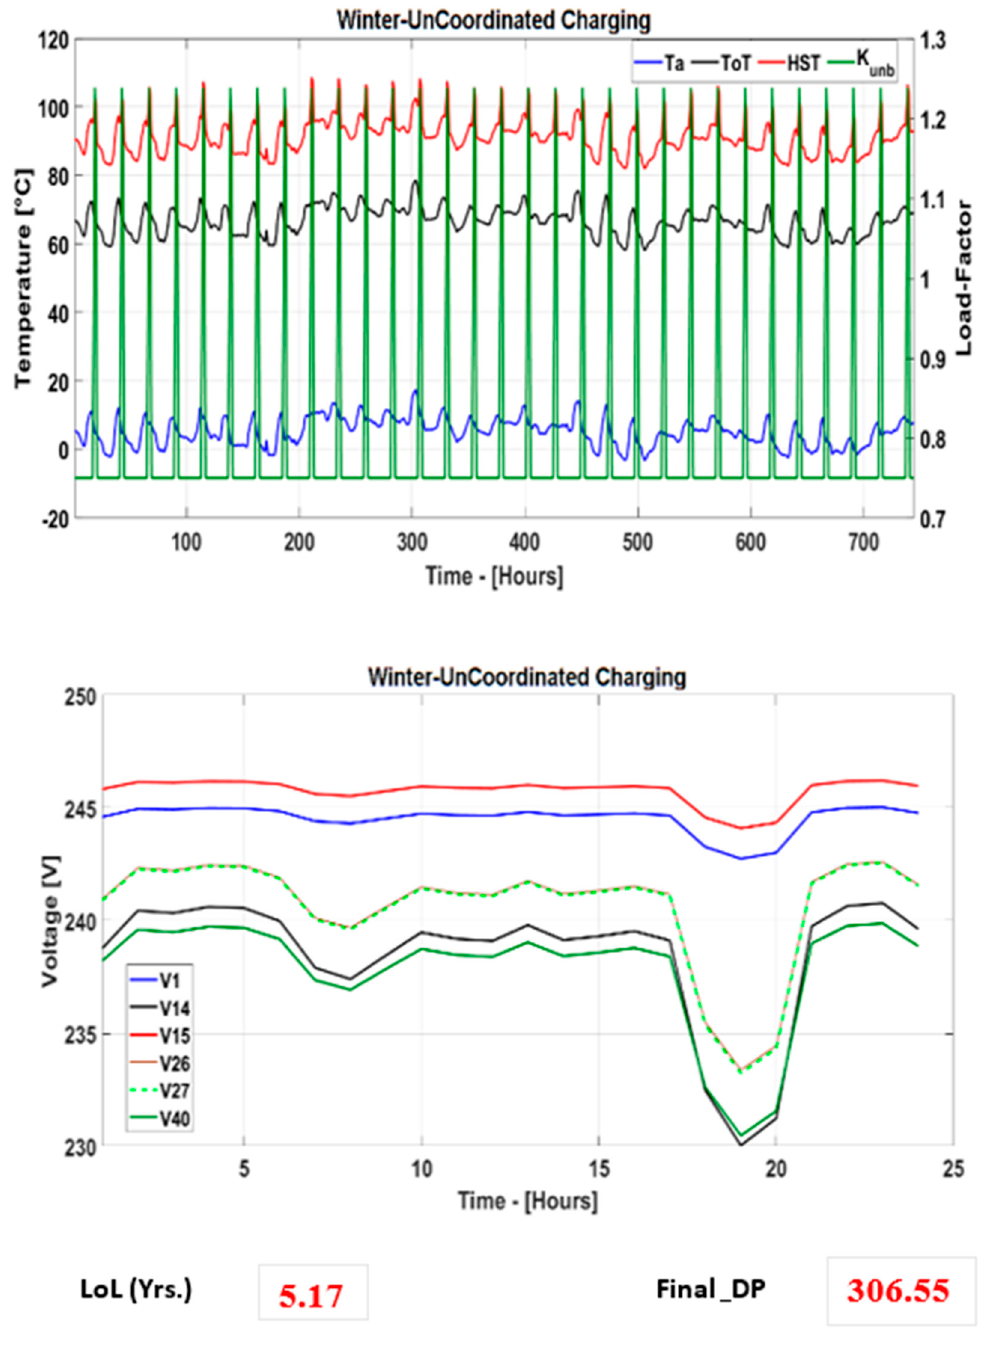
Figure 4. Output under uncoordinated charging across selected households, during winter, with BESS.